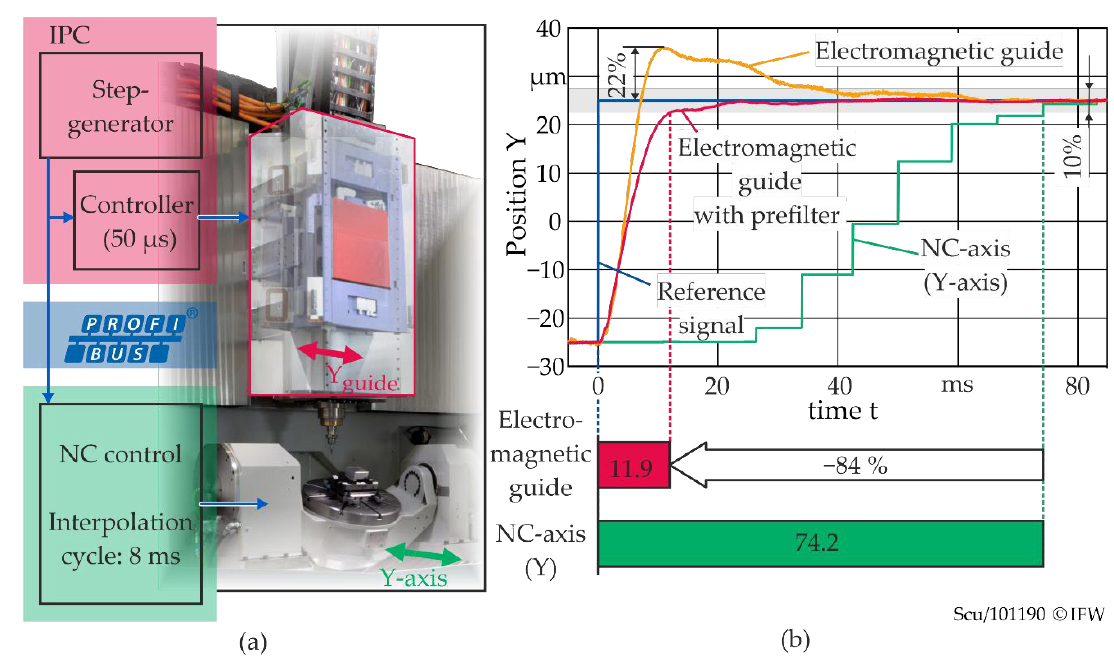
Figure 2. ( a ) Control architecture and setpoint generation. ( b ) Dynamic positioning behaviour. Step-response for a reference step of 50 µm.